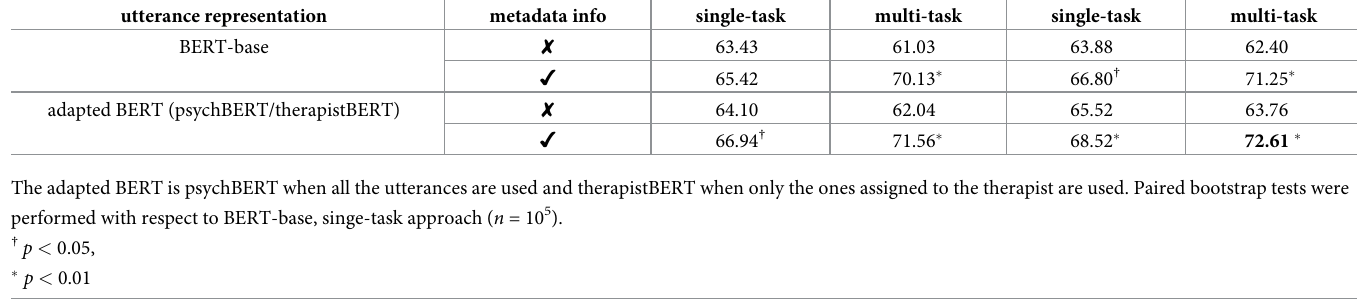
Table 6. Contribution of each proposed technique to the performance of the system.